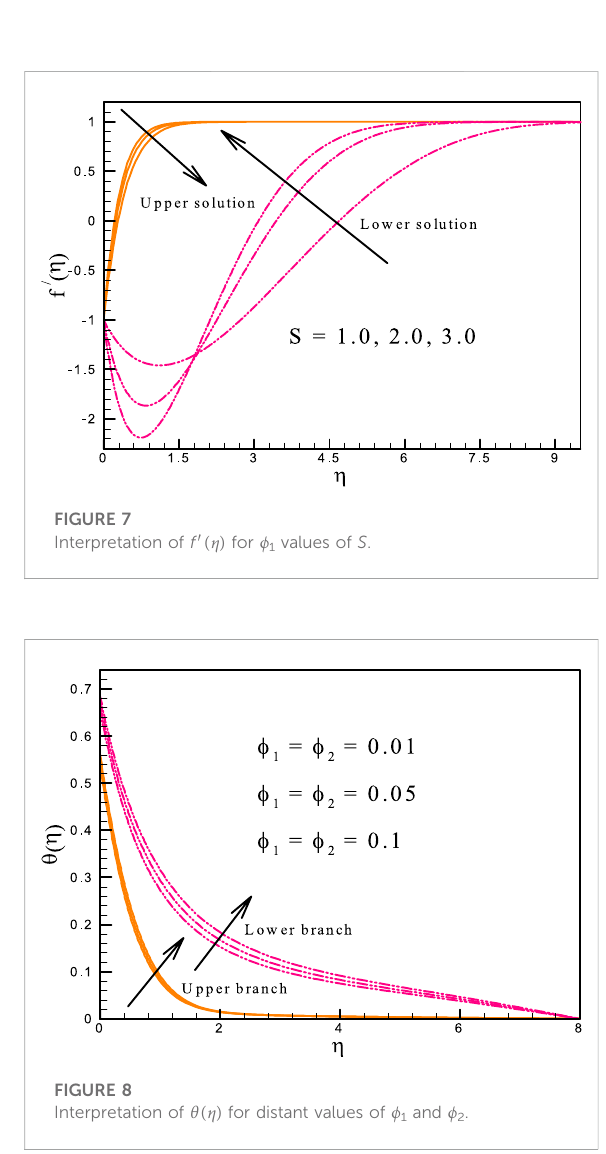
FIGURE 6 Interpretation of f ′ ( η ) for distant values of χ